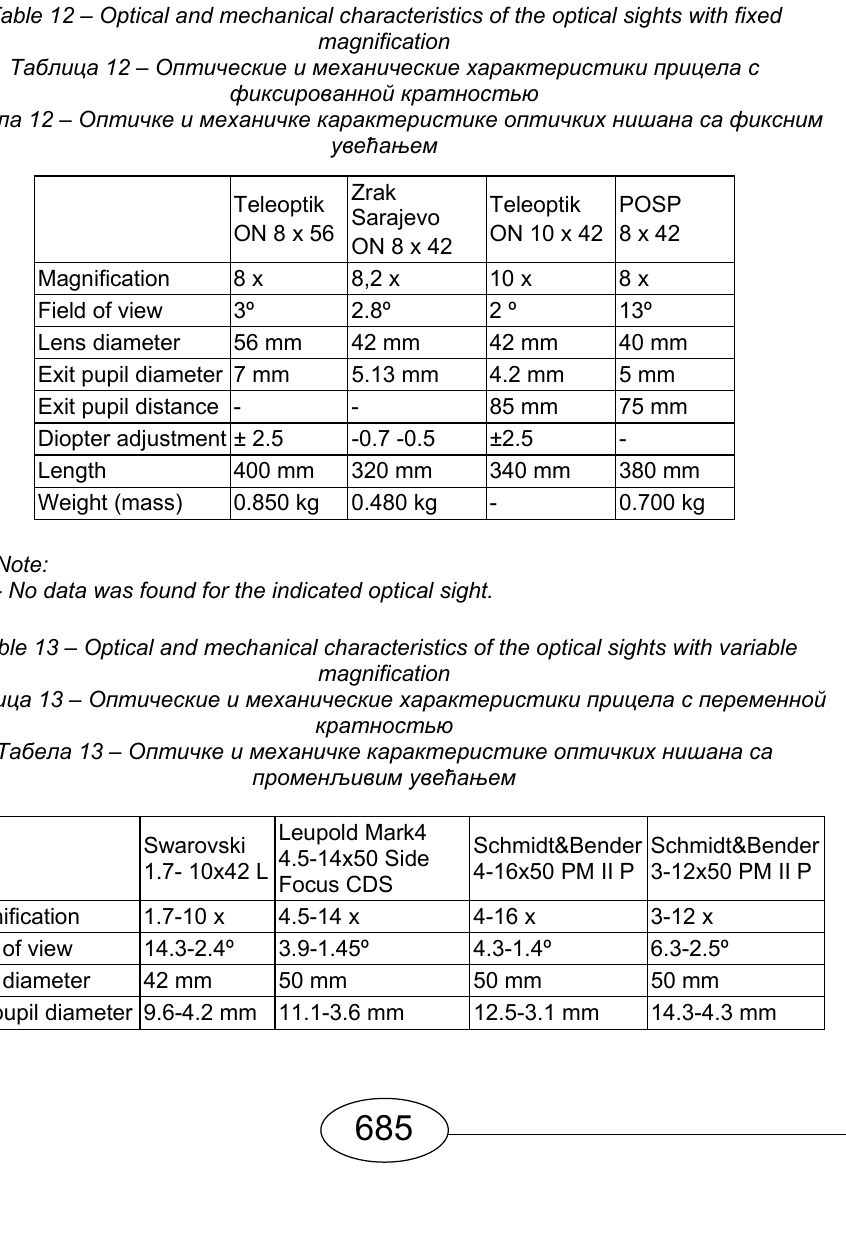
Table 12 – Optical and mechanical characteristics of the optical sights with fixed magnification